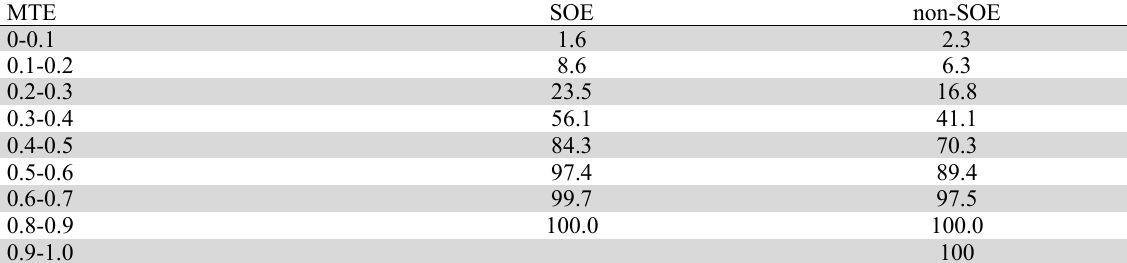
MTE for SOE and for non-SOE in different percentiles, accumulated (in percentage) MTE SOE non-SOE